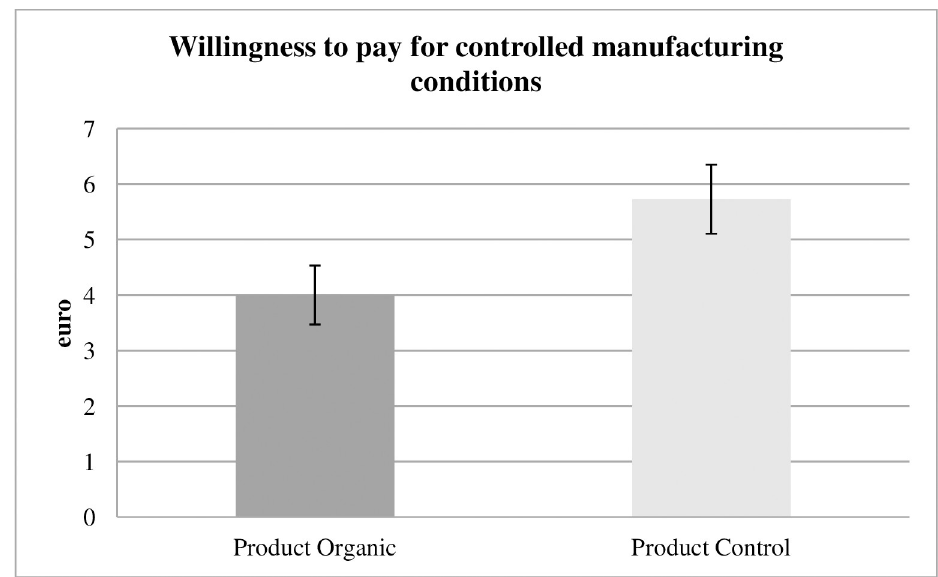
Fig 2. WTP product treatments. In Product Organic, subjects pay highly significantly less money to ensure controlled manufacturing standards compared with Product Control. Thus, static moral self-licensing takes